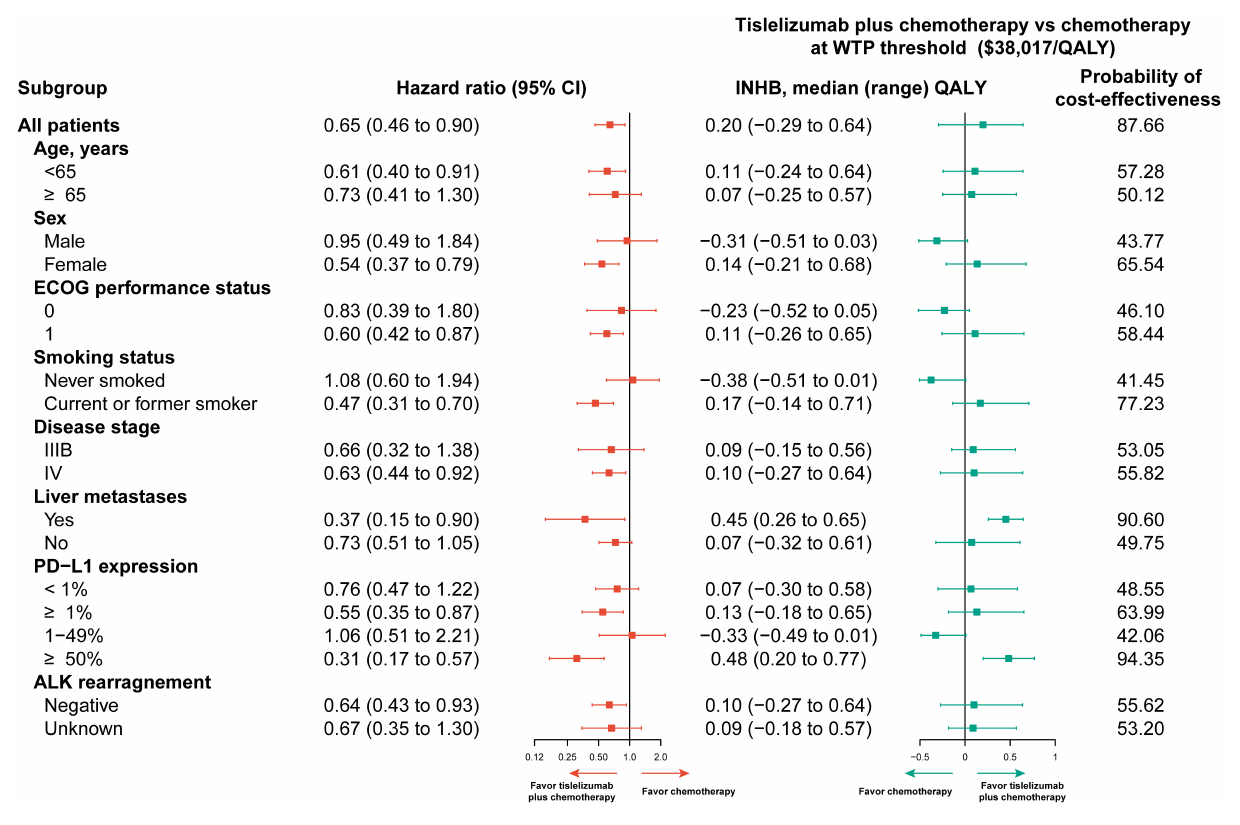
FIGURE2 Subgroup analyses. Subgroup analyses. CI, confidence interval; ECOG, Eastern Cooperative Oncology Group; ICER, incremental cost-effectiveness ratio; INHB, incremental net health benefits; PD-L1, programmed cell death ligand 1; QALY, quality-adjusted life-year; WTP, willingness to